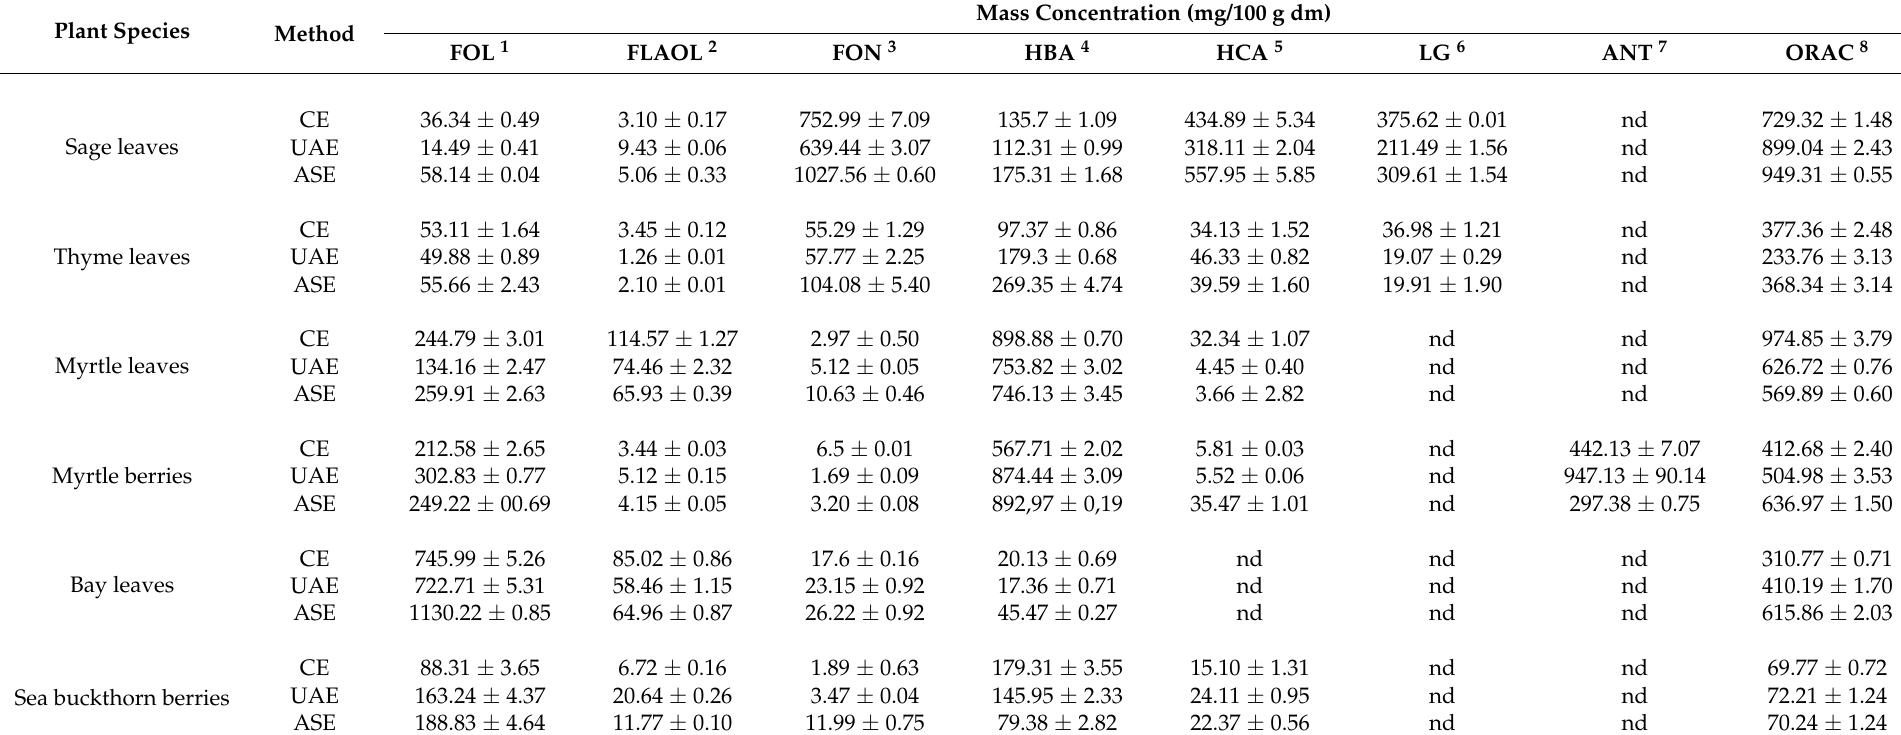
Table 2. Mass concentration of total flavonols, flavan-3-ols, flavones, phenolic acids (hydroxybenzoic and hydroxycinnamic acids), anthocyanins, lignans and its derivates determined in bay ( Laurus nobilis L.) leaves, sage ( Salvia officinalis L.) leaves, thyme ( Thymus vulgaris L.) leaves, myrtle ( Myrtus communis L.) leaves and berries and sea buckthorn ( Hippophae rhamnoides L.) berries extracts obtained by different extraction